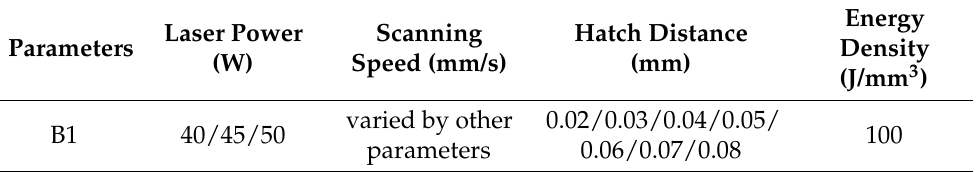
Table 3. The parameters adopted for optimization of printing TWS with the same energy